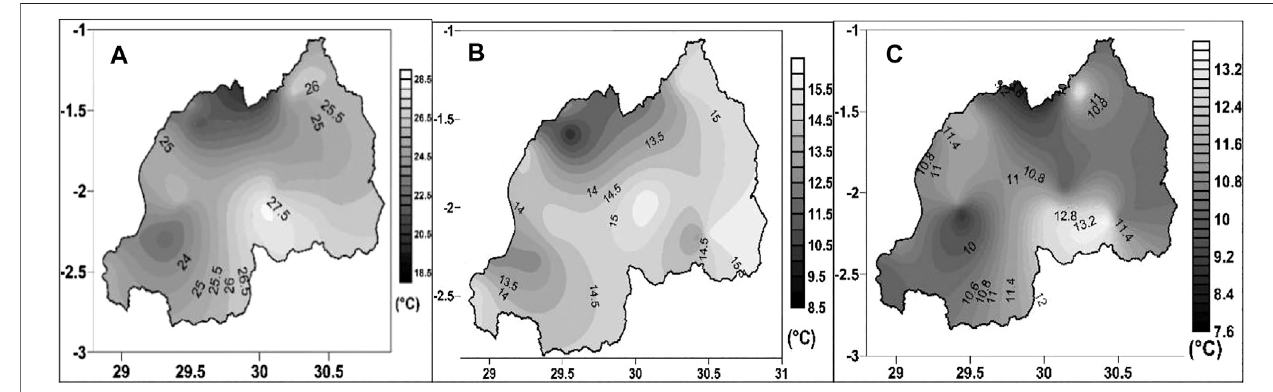
FIGURE 2 | Distribution of (A) Minimum, (B) Maximum and (C) diurnal temperature over Rwanda for the period of 1961 – 2014. Unit ( ° C) (Note: X -axis refers to longitude while Y -axis stand for latitude).